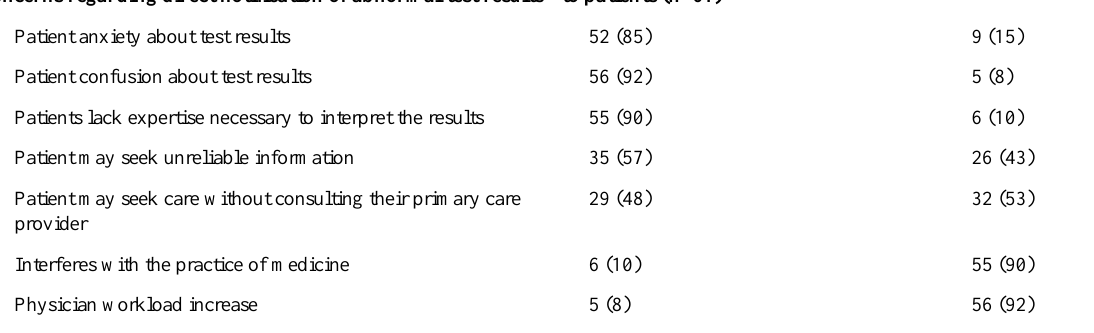
Table 3. Emergency physicians’attitudes toward direct notification. Attitudes to direct notification of test results to patients